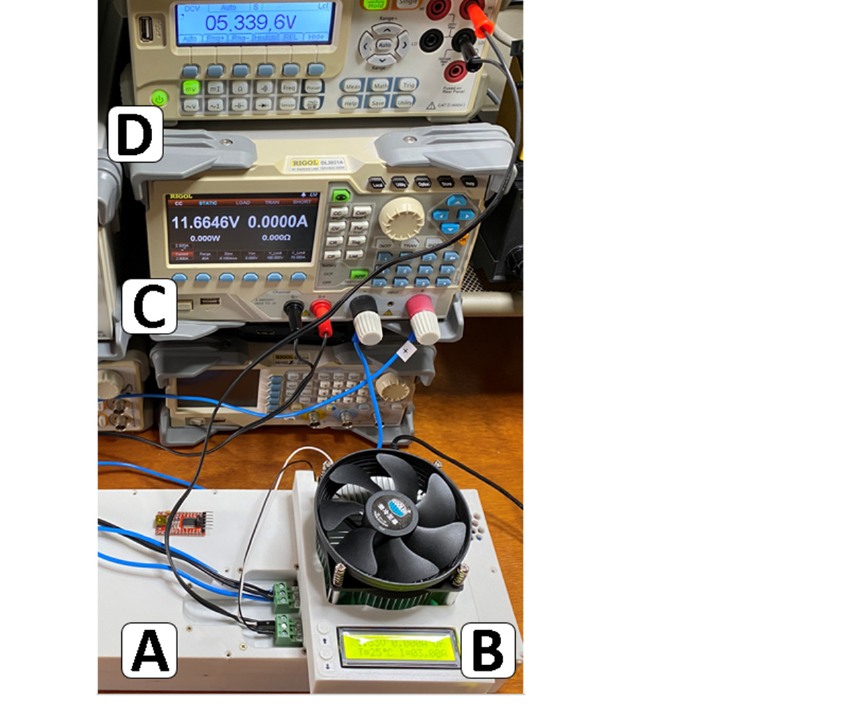
Figure 15. Voltage curve test setup used: A—Power supply, B and C—Electronic load, D—Multi- meter.